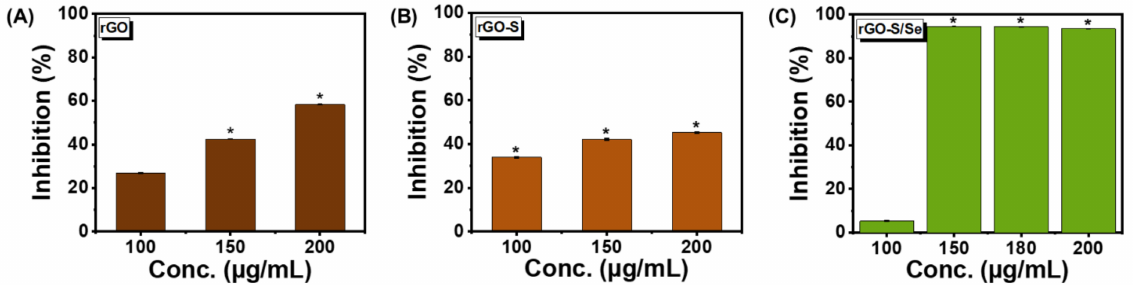
Figure 3. Effect of rGO, rGO-S, and rGO-S/Se on S. aureus growth. Percentage of bacterial growth inhi- bition when exposed to varying concentrations of ( A ) rGO; * p -value < 0.05, ( B ) rGO-S; * p -value ≤ 0.01 and ( C ) rGO-S/Se; * p -value < 0.0001. Error bar represents the standard error of the